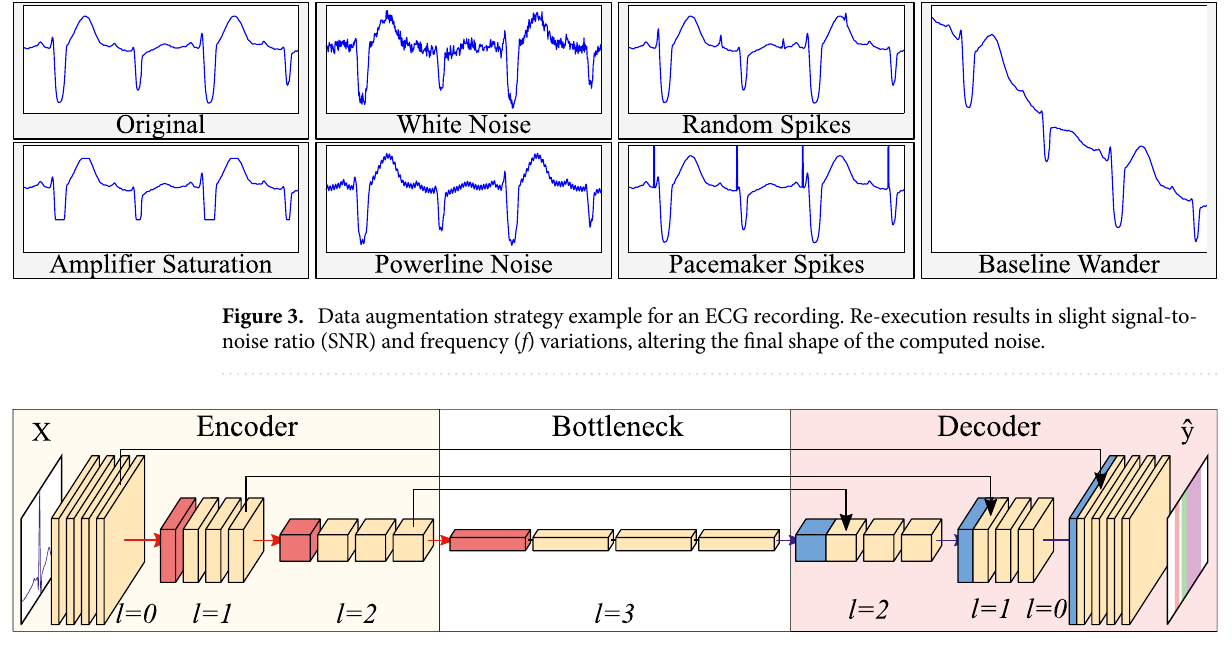
Figure 4. Base U-Net instantiated with 4 levels and 3 convolutional blocks per level. Blocks represent output tensors, whereas arrows indicate operations. Yellow: convolutions; red: pooling; blue: upsampling; black: l N concatenation. Convolutional operations extract 2 channels per level, whereas pooling and upsampling have a kernel size of